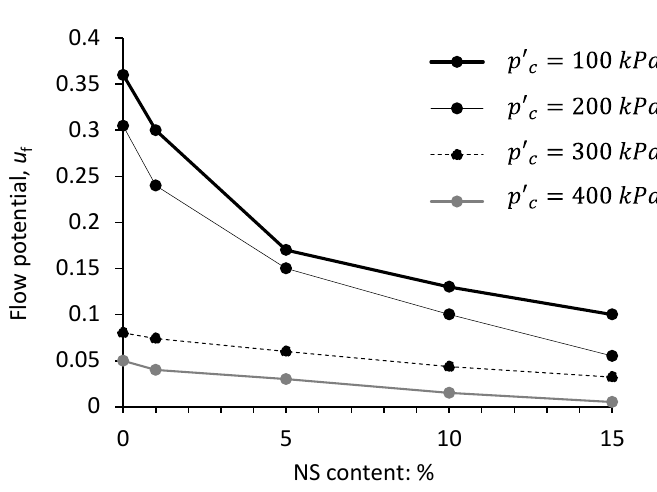
Figure 8. Variation of flow potential with nano-silica content.